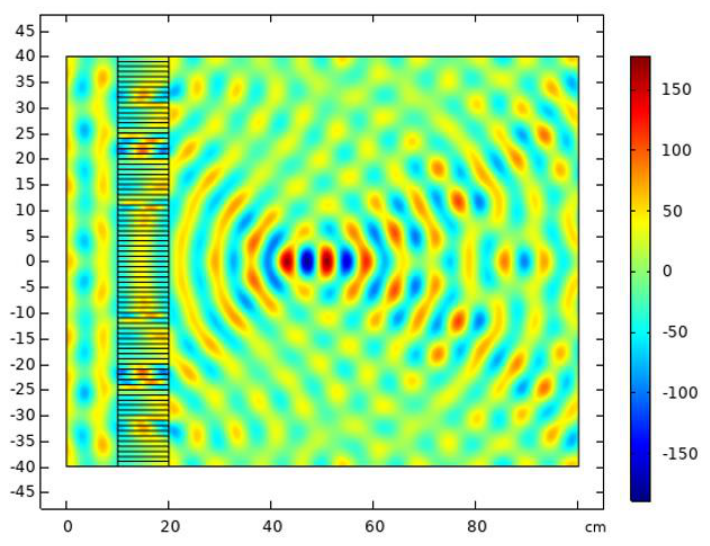
Figure 7. Spatial distribution of acoustic pressure field through focusing lens at 20 kHz.